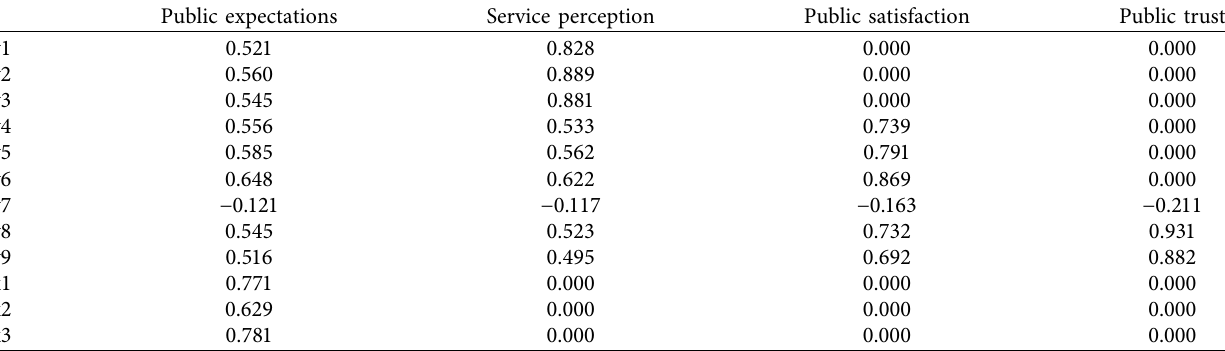
Table 12: Estimates of standardized total effect.